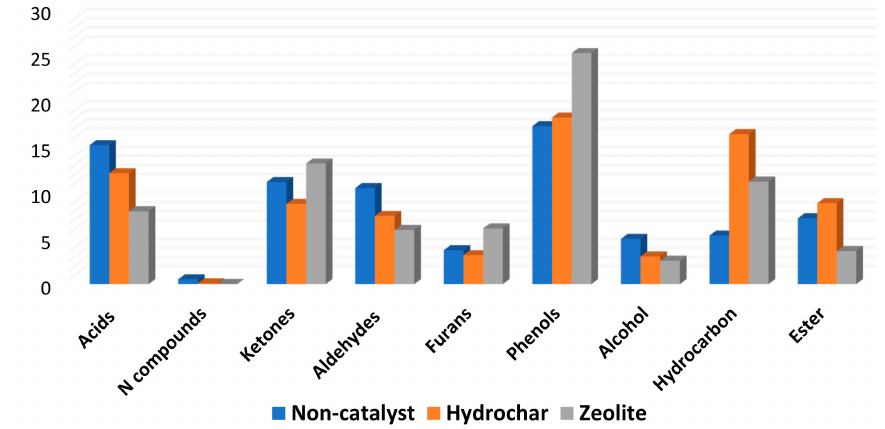
Figure 2. In-depth investigation of biocrude in terms of functional groups.